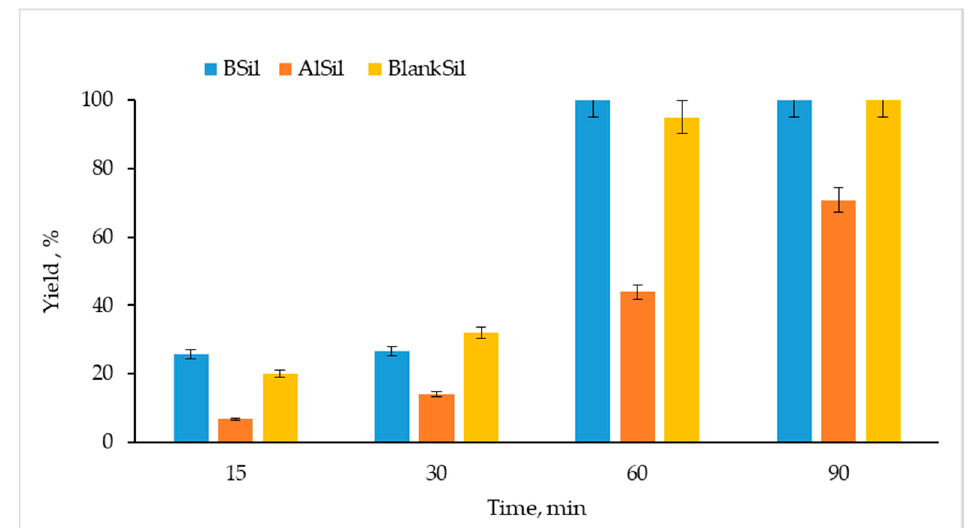
Figure 5. Efficiencies of OA esterification with methanol catalyzed by the immobilized catalysts (BSil, AlSil, and BlankSil) under ultrasonic activation for 15–90 min.